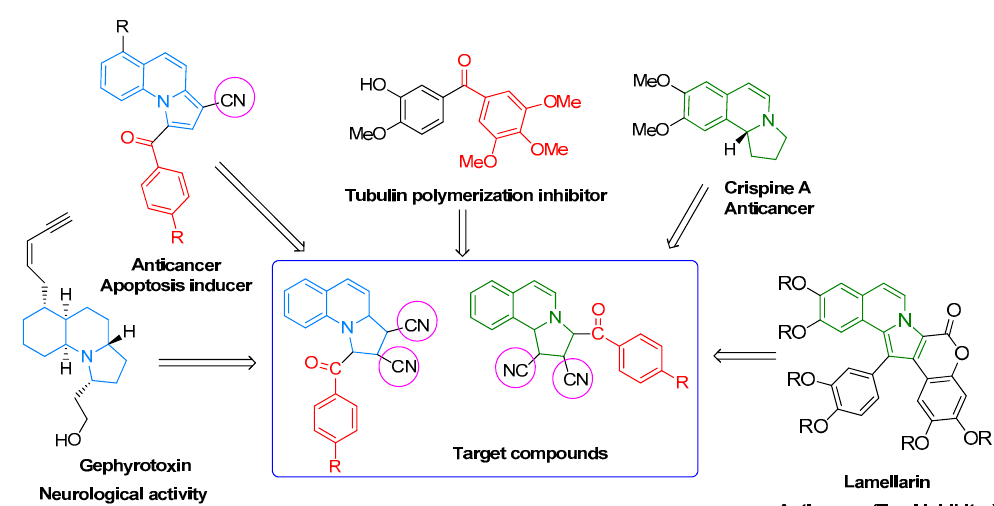
Figure 1. Design in the class of cyano-substituted pyrrolo(iso)quinolines.